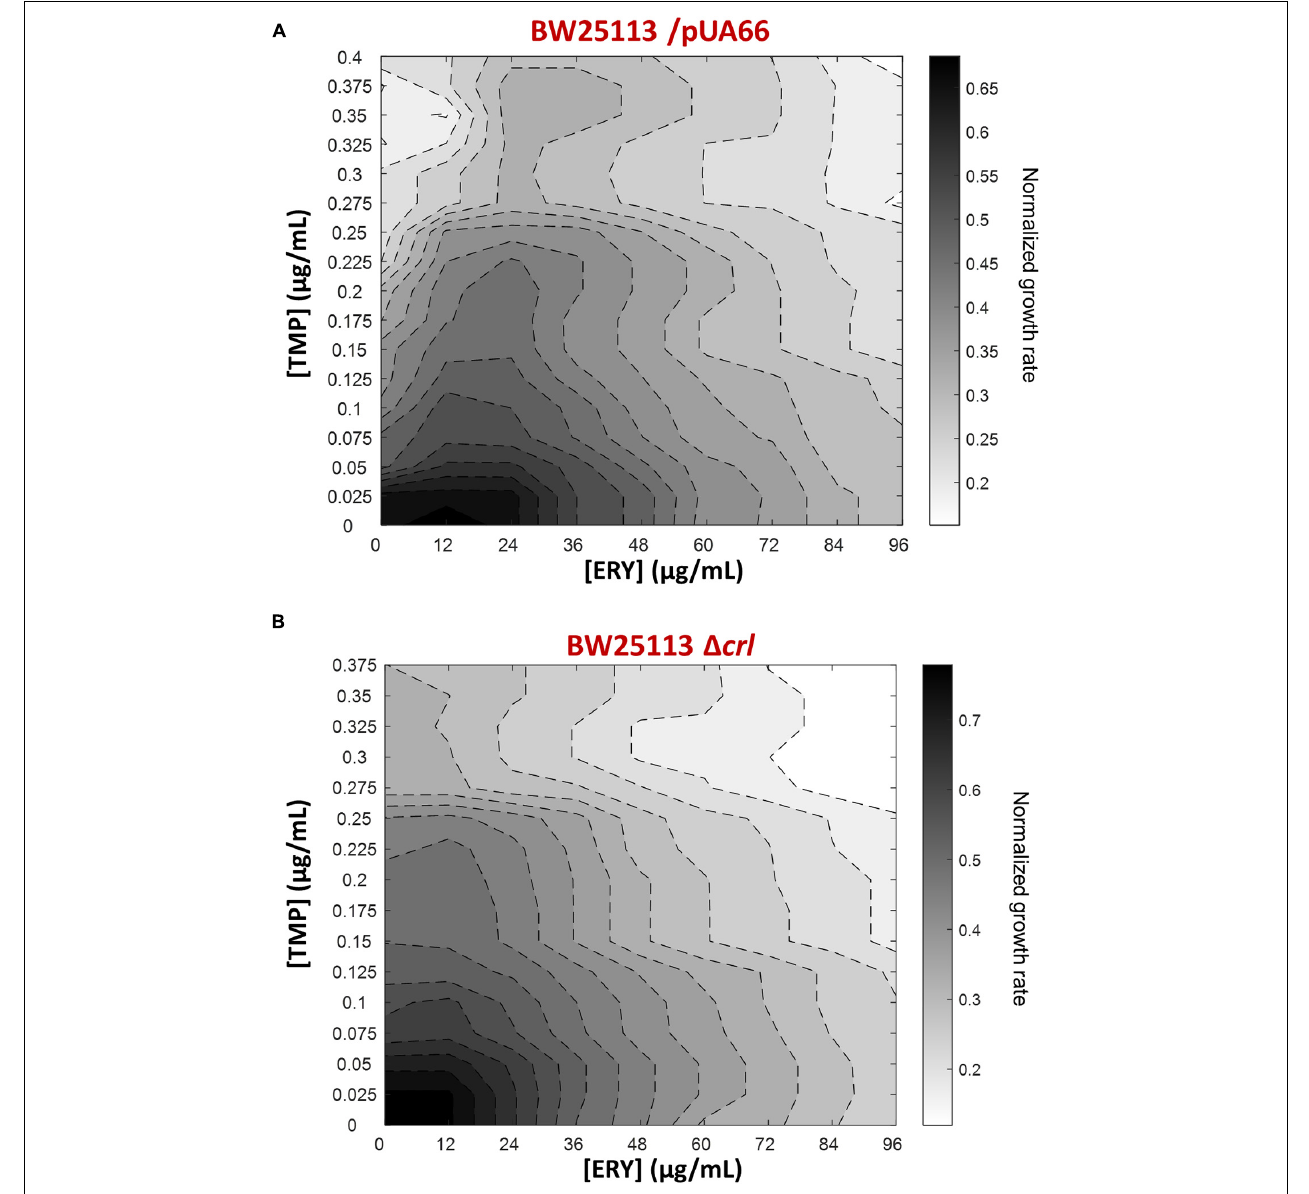
FIGURE 5 | The suppressive effect of ERY on TMP requires the presence of the crl gene in BW25113. Isoboles for TMP + ERY drug combinations for the E. coli BW25113/pUA66 and BW25113 (cid:49) crl strains. Whereas ERY exerts a strong suppressive effect on TMP when tested against the BW25113/pUA66 strain which has an intact crl gene (A) , the suppression is removed when tested against the BW25113 (cid:49) crl strain (B)